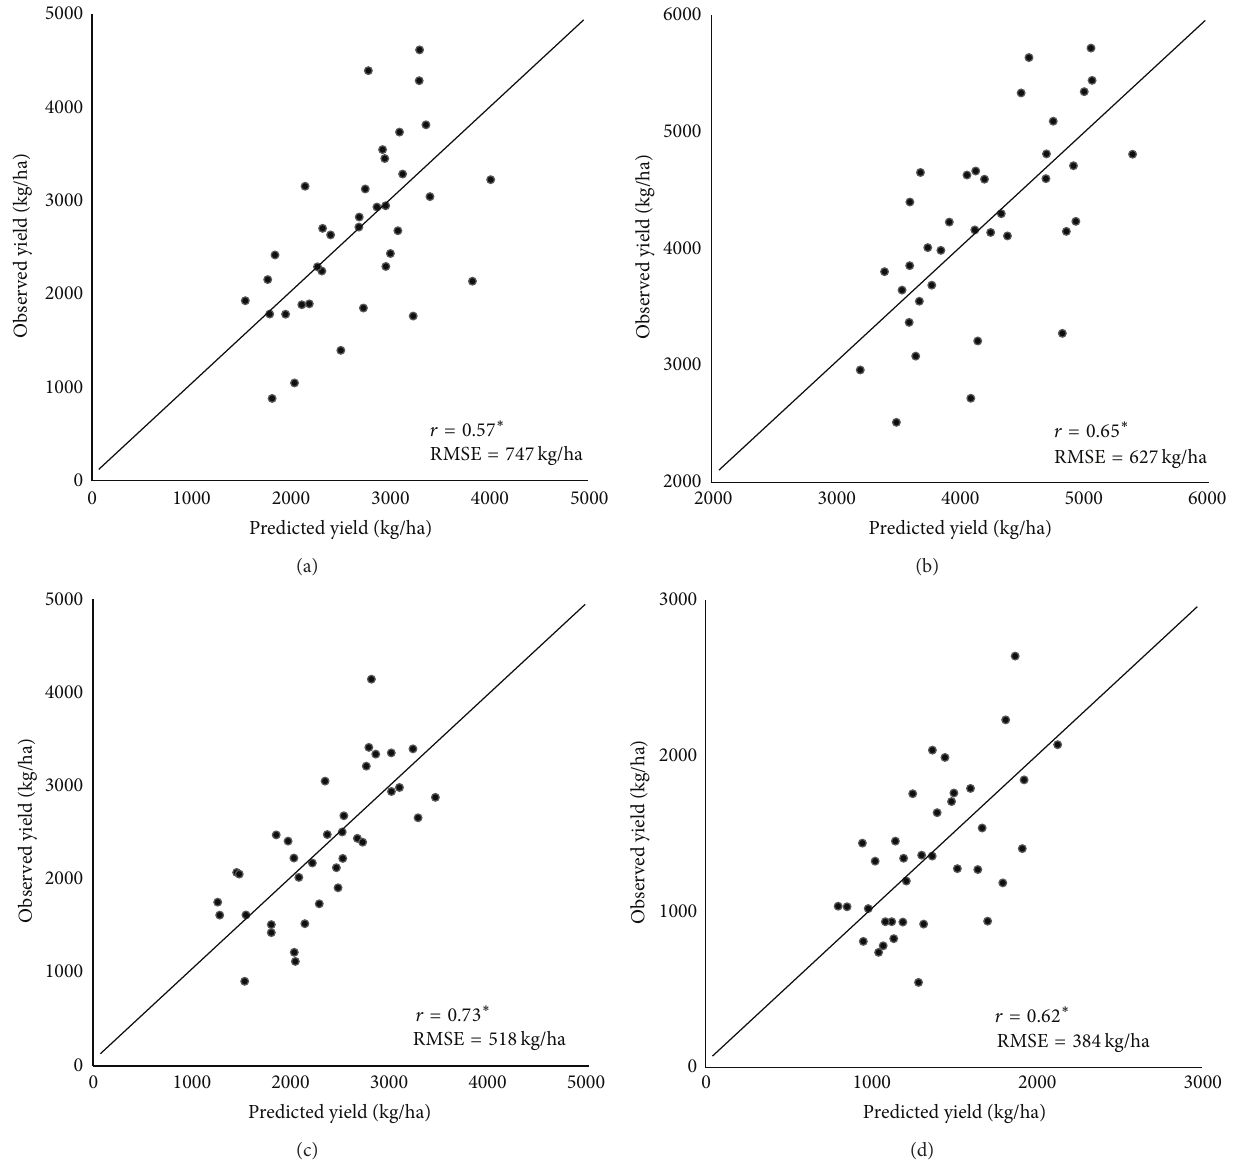
Figure 1: Observed and cross-validated strawberry yield forecasts for Santa Maria region for April (a), May (b), June (c), and July (d).